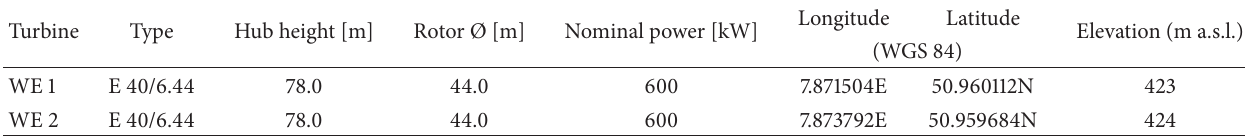
Table 12: Coordinates and data of wind turbines at the site Wenden .